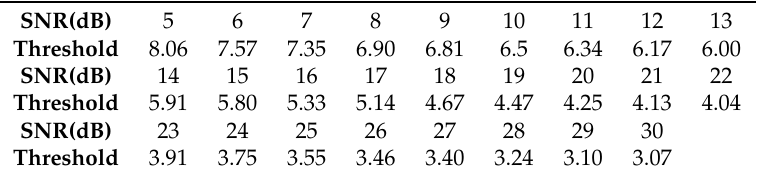
Table 1. Thresholds of soft information for different